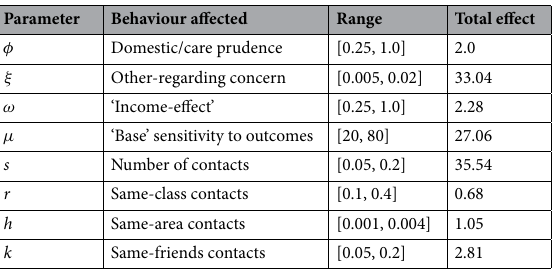
Table 1. Sensitivity